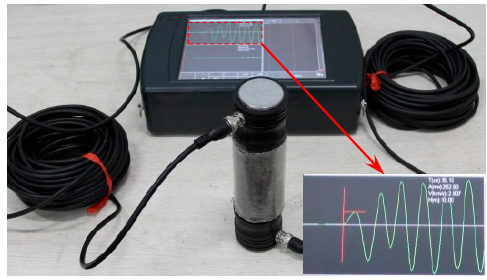
Figure 2. Ultrasonic automatic cycle tester.